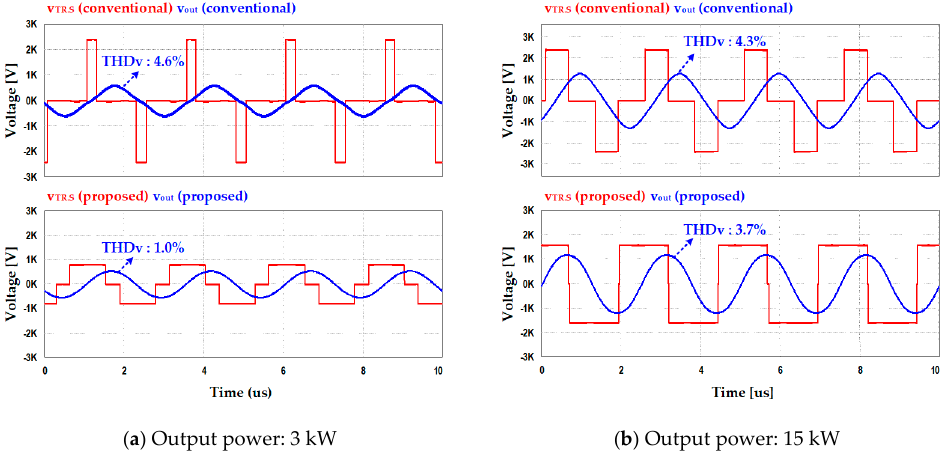
Figure 7. Waveforms of DC-AC inverter according to the output power and control